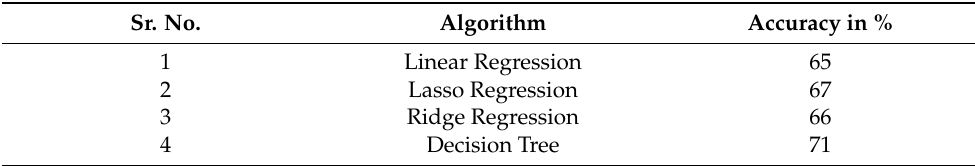
Table 5. Individual regression algorithm at level zero (L-0). Sr. No. Algorithm Accuracy in % 1 Linear Regression 65 2 Lasso Regression 67 3 Ridge Regression 66 4 Decision Tree